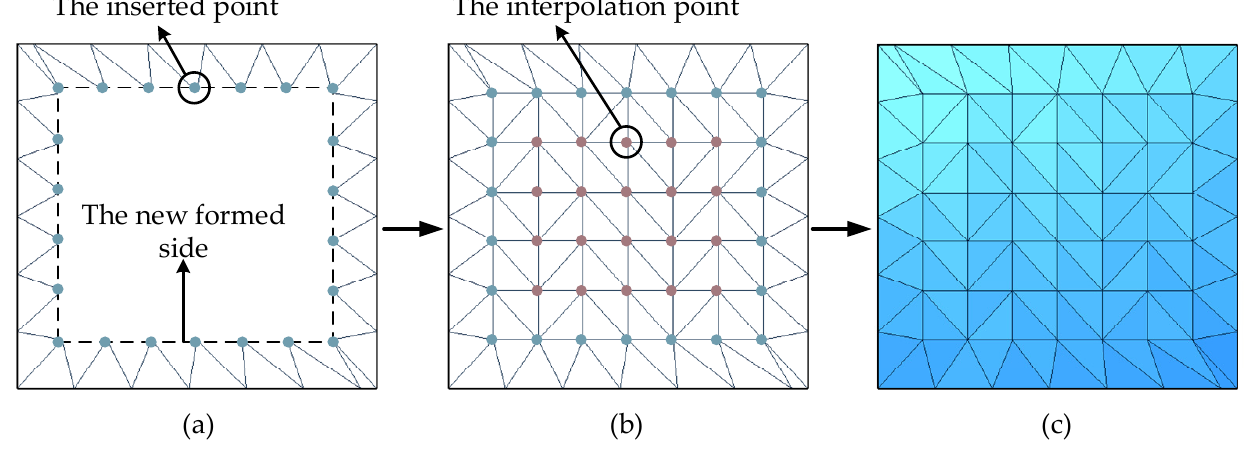
Figure 10. Schematic diagram of the four-sided region modeling:( a ) the preprocessed four-sided region; ( b , c ) the process and the result of the Coons surface interpolation and modeling.